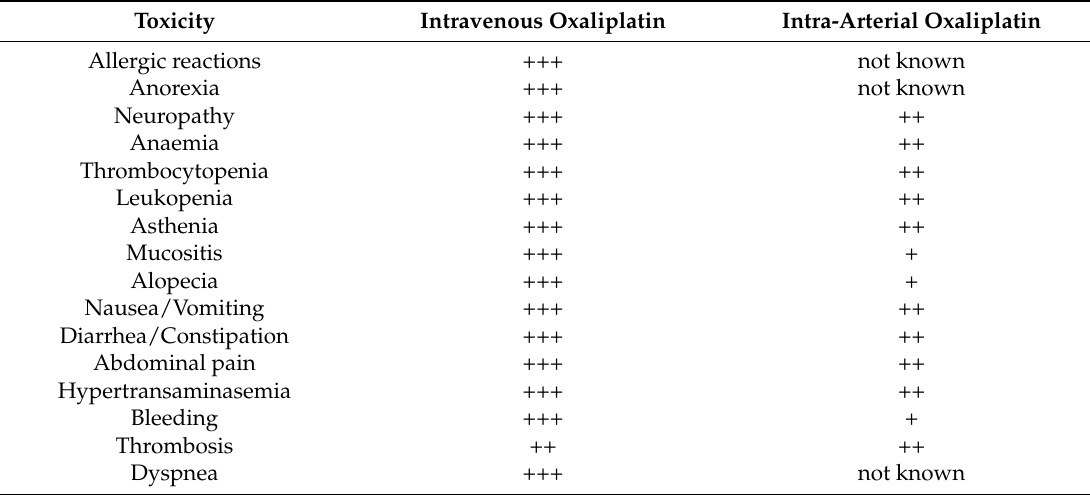
Table 1. Intravenous and intra-arterial oxaliplatin